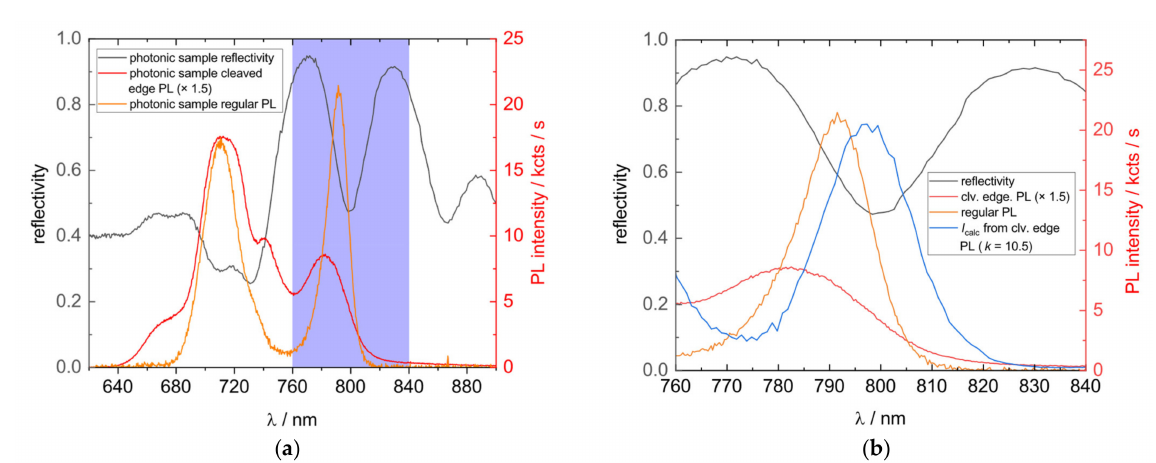
Figure 6. ( a ) Comparison of the measured reflectivity (black line), regular (orange line), and cleaved-edge PL (red line) of the photonic sample. For better comparability, a multiplication factor was used at the cleaved-edge PL spectrum. ( b ) Magnified area around the QD peak. The calculated PL spectrum ( I calc ), obtained by combination of the cleaved-edge PL and reflectivity spectrum is additionally plotted (blue line). The k value used is 10.5. PL measurements were performed at 100 K, while the reflectance was measured at room